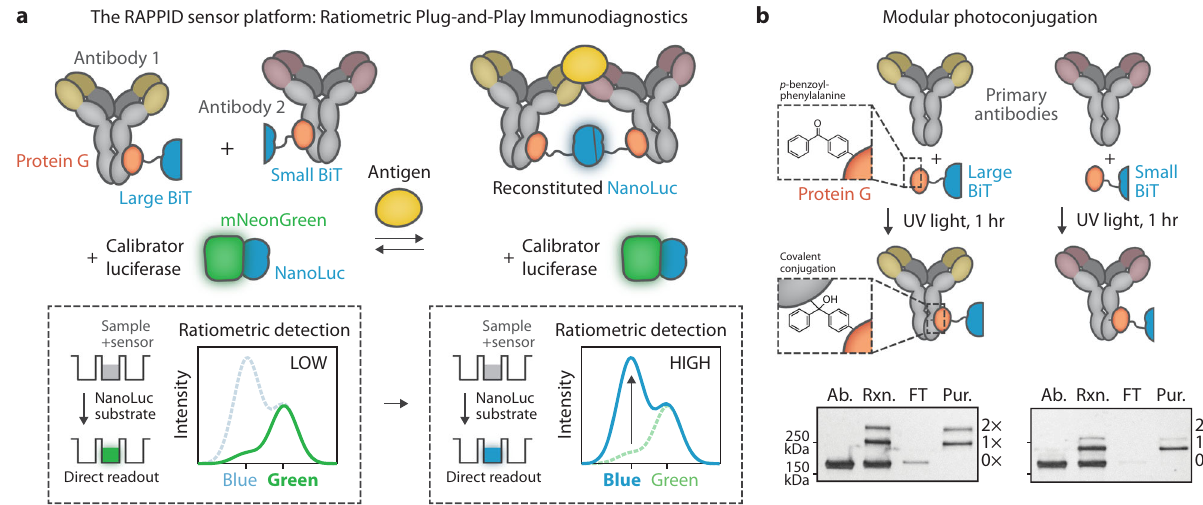
Fig. 1 General overview and design elements of the RAPPID sensor platform. a Schematic representation of the concept of antigen detection using a RAPPID sensor. A pair of primary antibodies is functionalized with a split version of the NanoLuc luciferase (large BiT and small BiT, respectively) through the use of protein G-based photoconjugation. Antigen binding induces colocalization of the antibody pair and subsequent reconstitution of NanoLuc, resulting in the emission of blue light upon conversion of the substrate (furimazine; λ max ~ 460 nm). Ratiometric detection is achieved by the addition of a calibrator luciferase, consisting of a tight fusion of NanoLuc to fl uorescent acceptor mNeonGreen, which produces a green signal ( λ max ~ 520 nm) upon substrate conversion through bioluminescent resonance energy transfer (BRET). The homogeneous solution-based assay is conducted by mixing the sample and sensor components with the NanoLuc substrate and recording the emission spectrum. In the absence of antigen (left) no split complementation occurs resulting in predominantly green emission from the calibrator luciferase (low blue/green ratio), while the presence of antigen (right) results in NanoLuc reconstitution and an increase in blue-light emission (high blue/green ratio). b Schematic overview of the antibody conjugation method. Fusion between the adapter protein G carrying the photoreactive non-natural amino acid p -benzoylphenylalanine and either large BiT or small BiT (Gx-LB and Gx-SB, respectively) enables covalent coupling to the constant Fc-binding domain of most IgG-type antibodies, including all human IgGs, by exposure to long- wavelength ultraviolet (UV) light ( λ = 365nm). Non-reducing SDS-PAGE analysis of the photoconjugation reaction (Rxn.) illustrates the successful coupling of primary antibody (Ab, 10 µ M) to either one (indicated with 1×) or two (2×) protein G adapters (10 µ M). Reactions were performed in PBS (pH 7.4) for 1 h on ice. Subsequent small-scale Ni 2 + -af fi nity chromatography removed unconjugated antibody (FT, fl ow-through) resulting in pure antibody conjugates (Pur.). Gel image depicts a representative image from n = 3 independent experiments, with similar results. Source data is provided in Supplementary Fig.